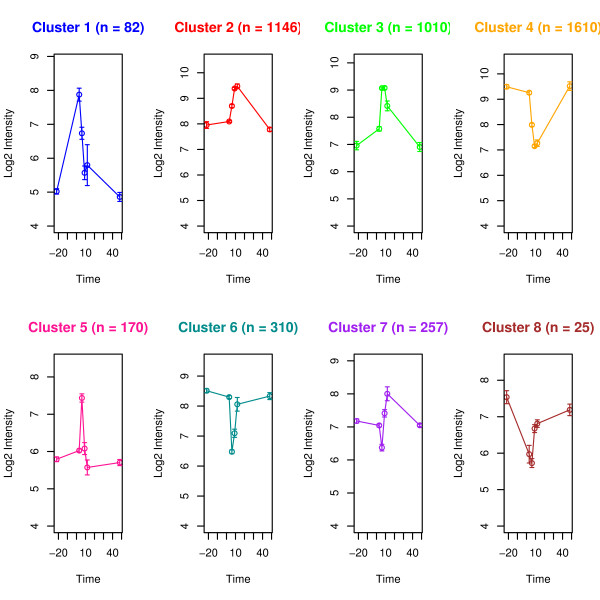
Expression profile of individual cluster. Each expression profile corresponds to a sub-tree (color match) in Figure 1. The cluster size (number of transcripts) is shown inside parenthesis. Y-axis represents the average value of log2-transformed expression intensity and x-axis represents the time series chronologically (-22, 3, 6, 9, 12, 48) subject to LPS treatment. A description of the genes included in each clusters are given in the result section.